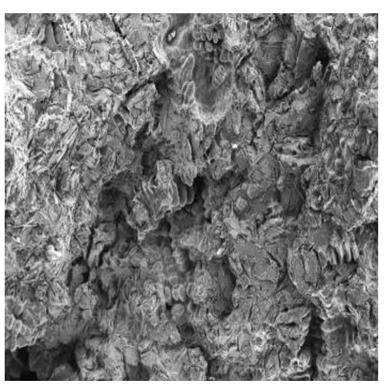
EDS spectrum of AL/Mica/SiC composite .